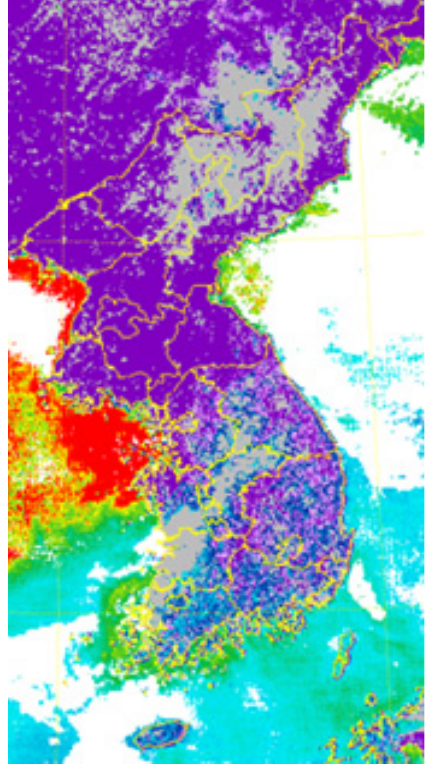
Figure 2. Cropped satellite image of the Korean Peninsula.